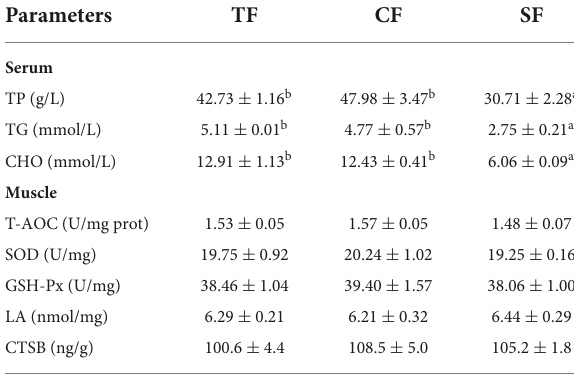
TABLE 9 Serum and flesh biochemical indices of largemouth bass fed trash fish and formula feeds.